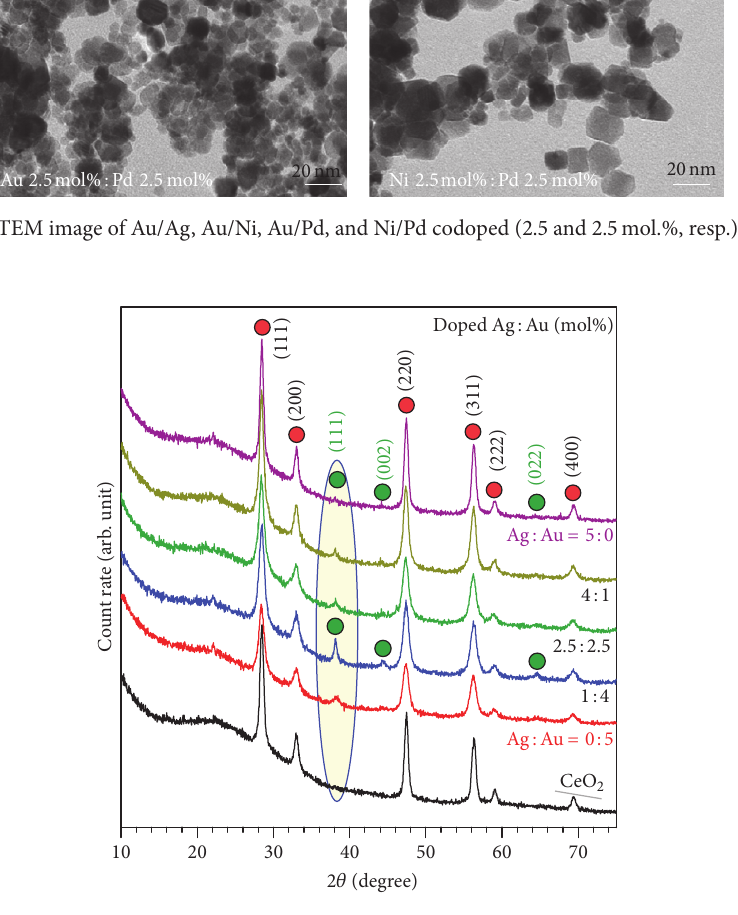
Figure 2: Power X-ray diffraction patterns of undoped CeO 2 and Au and Ag doped and codoped (0/5, 4/1, 2.5/2.5, 1/4, and 5/0 mol.%, resp.) CeO 2 catalysts. The red and green filled circles are of cubic CeO 2 and Au phases,